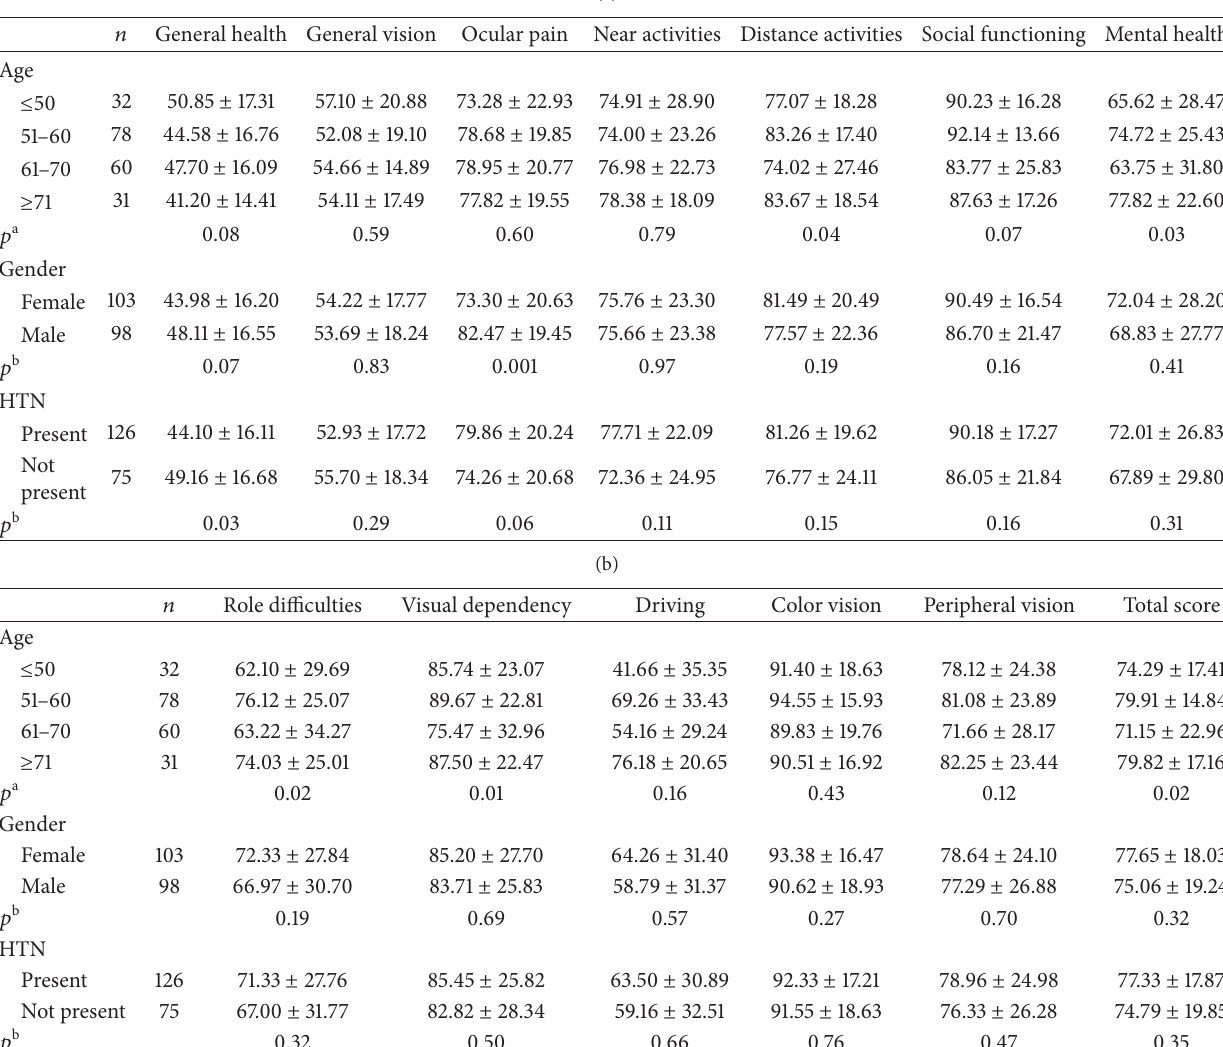
Table 6: Questionnaire scores according to demographic